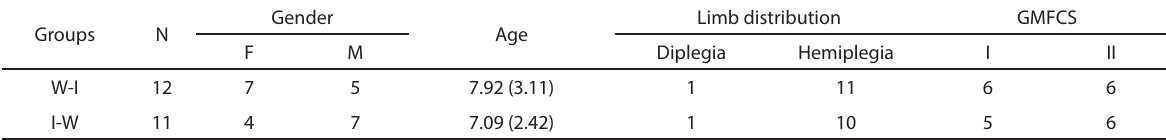
Table 1. The GMFCS levels and topographic distribution of the